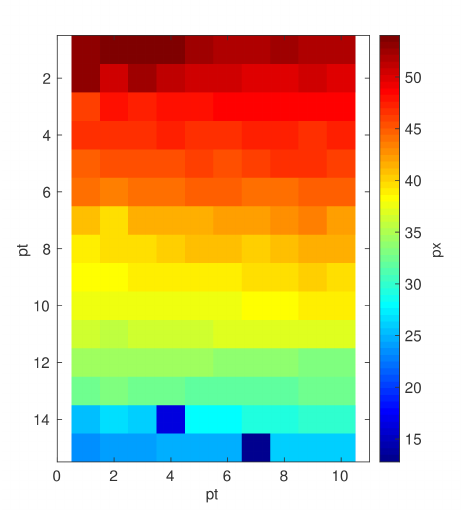
Figure 5. Map of the total displacements of points.